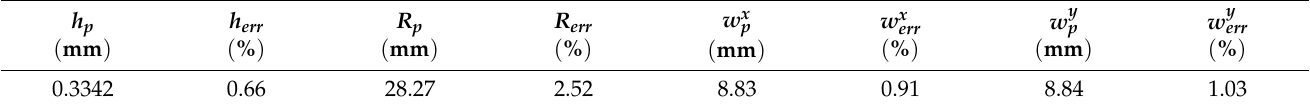
Table 6. Reconstructed surface parameters of samples without missing points and more points.